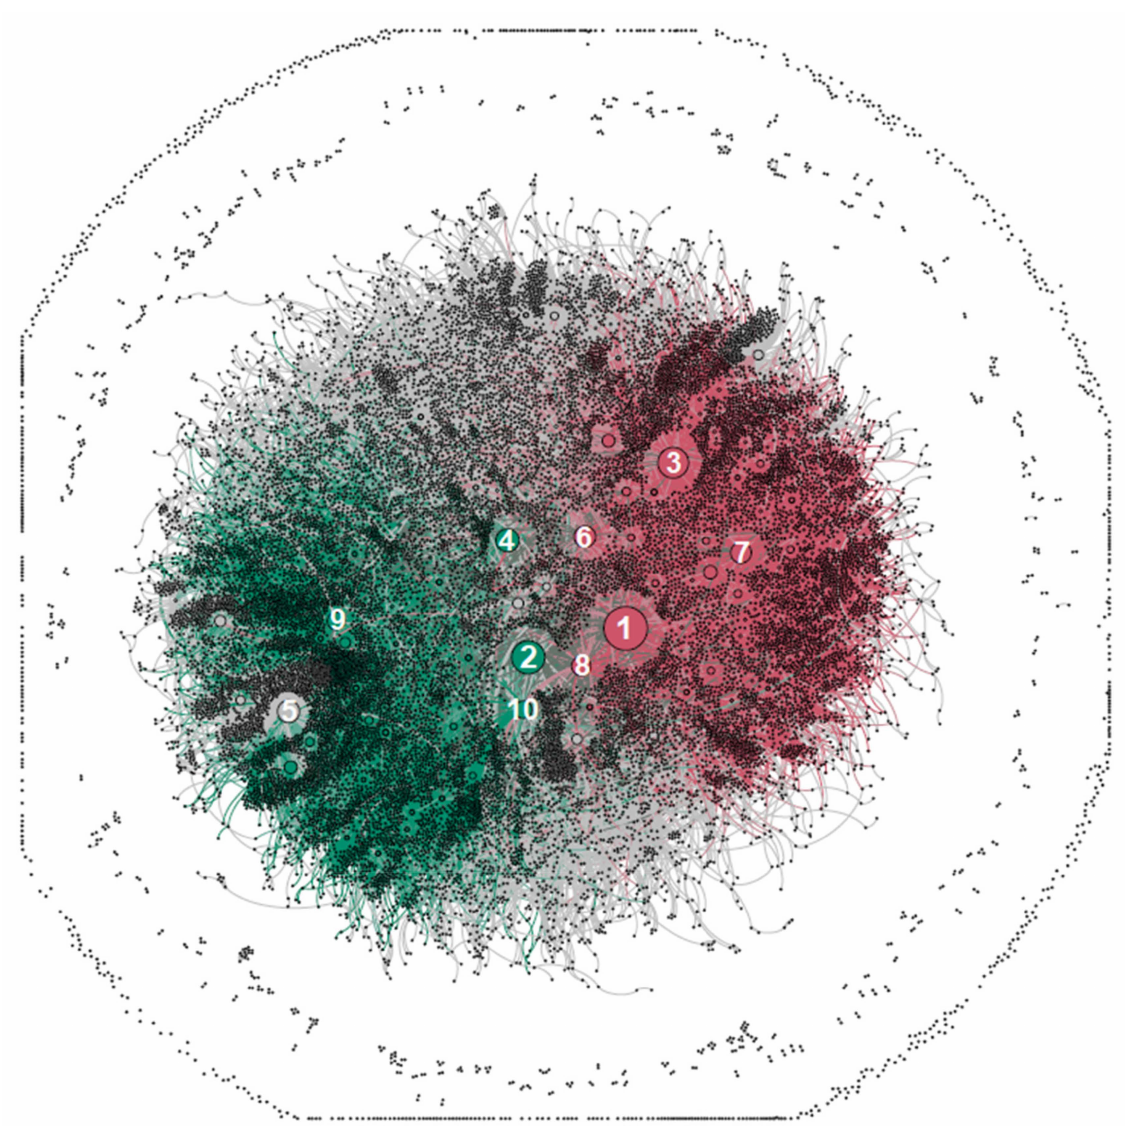
Figure 1. Social network graph of 21,779 Twitter users debating mandatory COVID-19 vaccination in Poland between 26 July 2021 and 9 December 2021. The two largest groups of users distinguished by the clustering algorithm are G1, marked with dark green (vaccination mandate advocates) and G2, marked with dark pink (vaccination mandate opponents). The users that did not belong to either of these two groups are visualised in grey. The 10 most influential users according to the betweenness centrality (BC) score are numbered from 1 to 10. The larger the nodes, the greater the BC score, and thus the more critical its position on the graph. The nodes on the outskirts of the graph, not connected with any other, belong to the isolates group, i.e., the users who sent tweets that did not contain